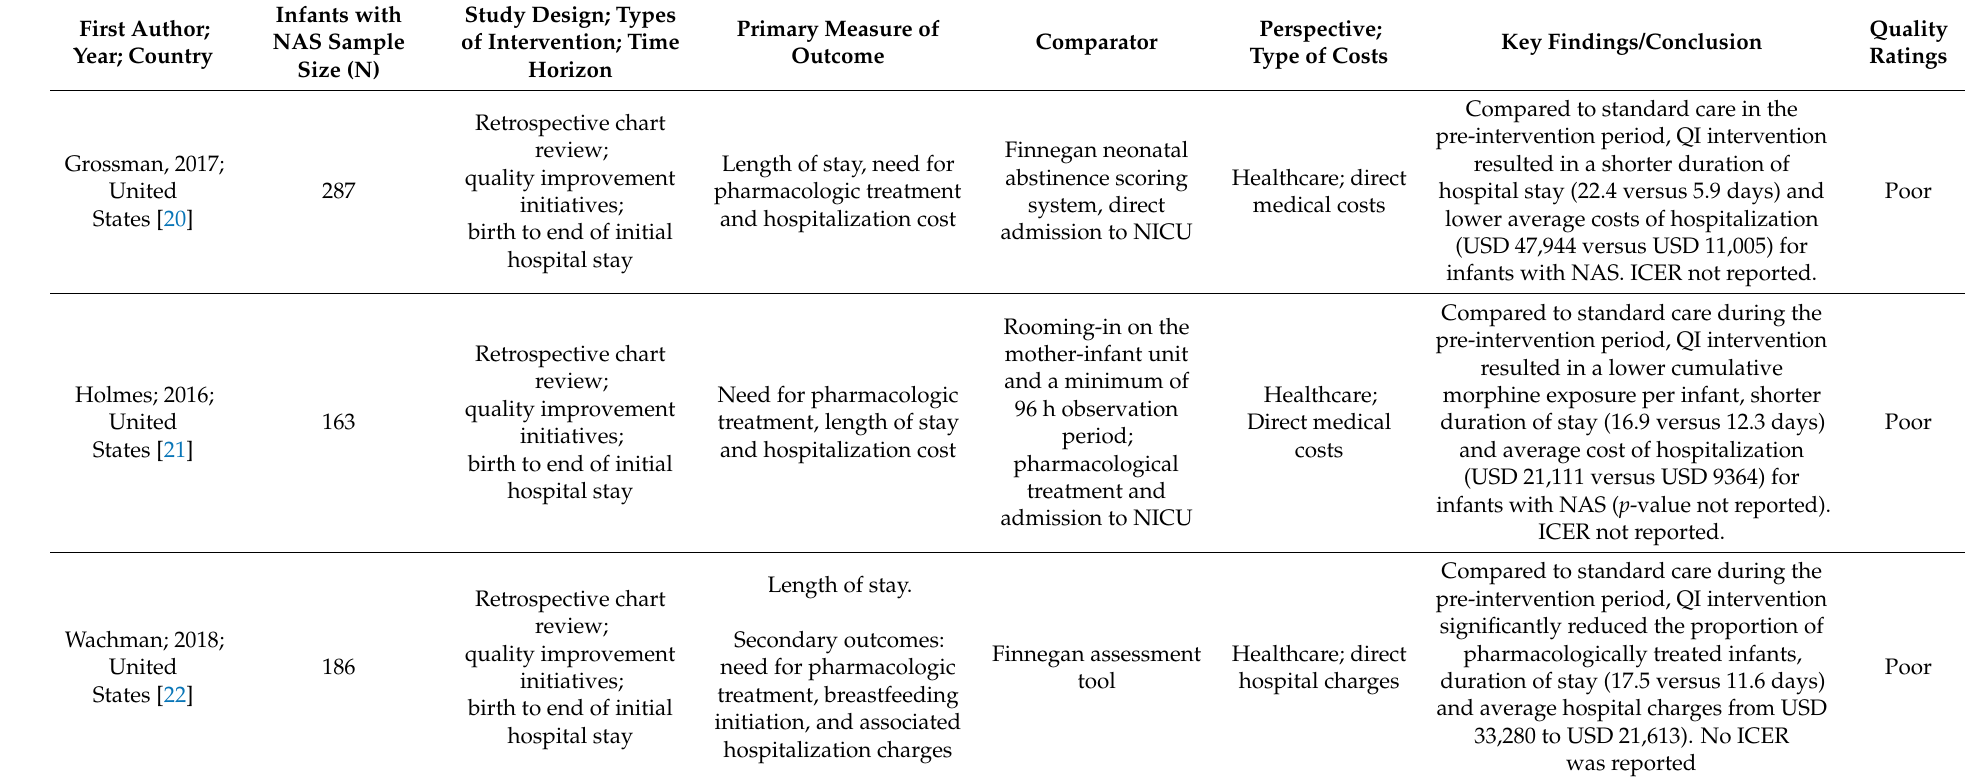
Table 2. Characteristics of included